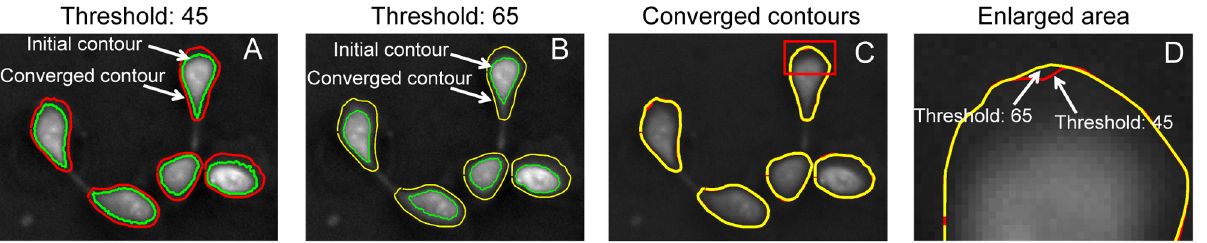
Fig 9. The contour expansion operation is robust to the selected threshold value. The contour expansion was performed with the initial contours obtained with threshold value of 45 (A) and 65 (B). The final converged contours are close to each other, as shown in (C), which implies that the contour expansion operation is robust with respect to the selection of threshold value. (D) The enlarged image for the selected area in